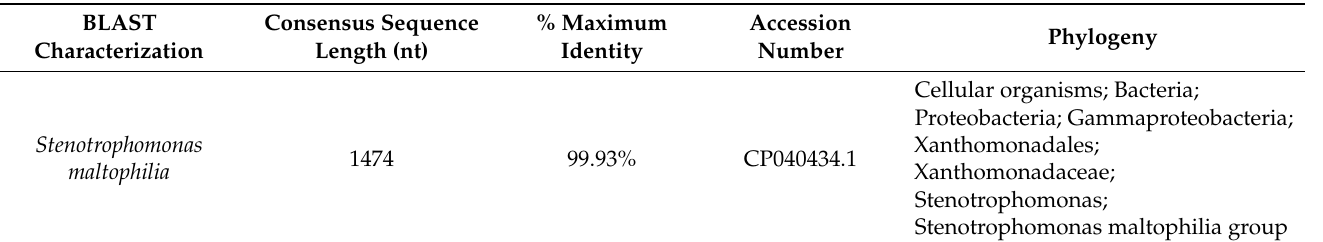
Table 1. BLAST characterization of the rDNA sequence of the bacterium isolated from the MFC anode plate.